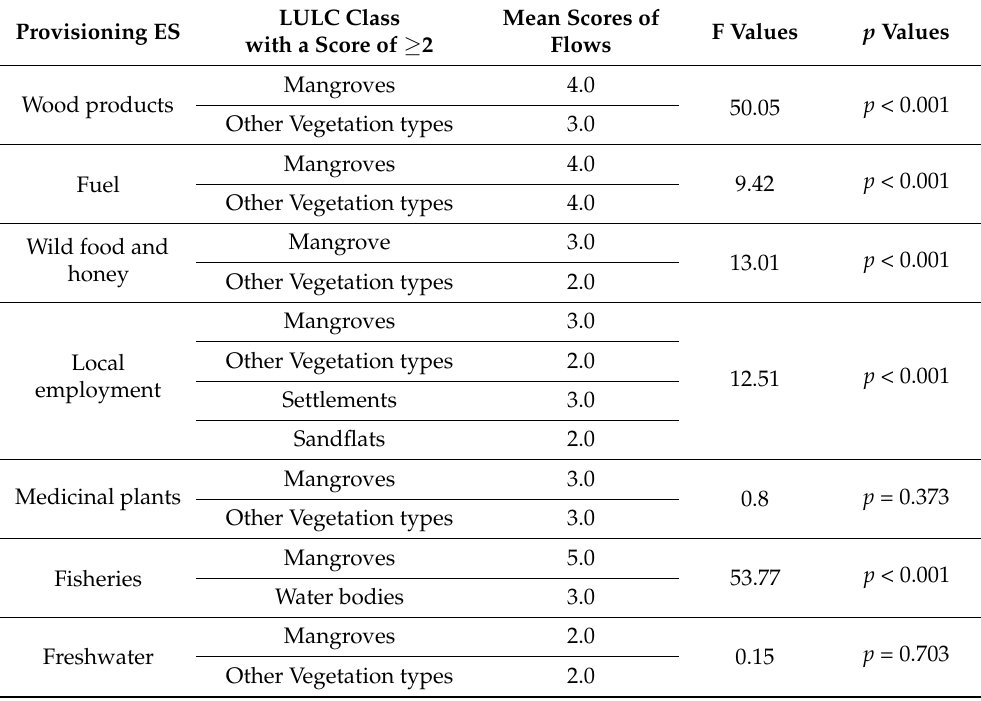
Table 3. Summary statistics of the one-way ANOVA-test for the assessment of flow provisioning ES from the LULC with high scores: n = 80 for Ungwana bay,